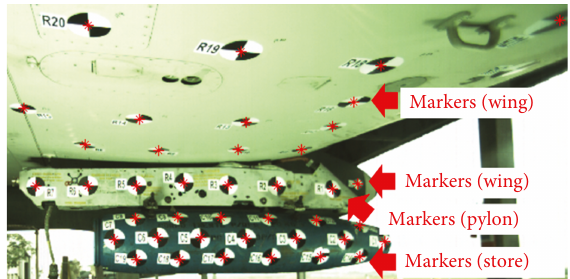
Figure 26: Image with markers identi fi ed in store, pylon, and aircraft.